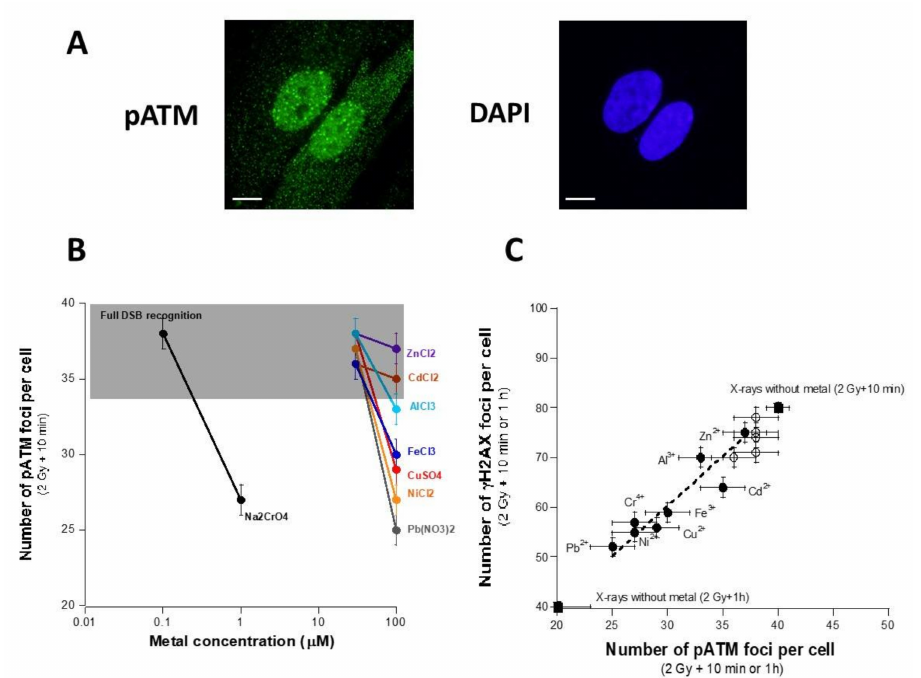
Figure 4. Delay of the ATM nucleo-shuttling after metal exposure. In the same conditions as described in Figure 3, anti-pATM immunofluorescence was applied to the radioresistant 149BR control cells to obtain pATM foci kinetics. ( A ) Representative example of images stained with anti-pATM antibody and counterstained with DAPI after 24 h exposure to 100 µ M AlCl 3 , X-ray irradiation (2 Gy) followed by 10 min for repair. The white bar represents 10 µ m. ( B ) The pATM data obtained after 10 min post-irradiation were plotted against the metal concentration. The grey zone corresponds to the numerical values when all the RI DSB are recognized. A decrease in the number of pATM foci is interpreted as a defect in the DSB recognition. Each plot represents the mean ± standard error (SEM) of at least three replicates. ( C ) The pATM data obtained after 100 mM metal exposure and 10 min (empty circles) or 1 h (black circles) post-irradiation shown in panel B were plotted against the corresponding γ H2AX data shown in Figure 3. The black squares indicate the γ H2AX and pATM data without metal exposure. Each plot represents the mean ± standard error (SEM) of at least three replicates. The dotted line represents the data fit with y = 2.0039x (r = 0.95) obtained from the 10 min